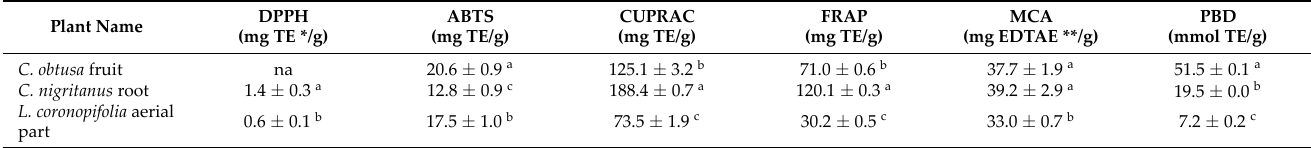
Table 4. Antioxidant activity of the essential oil of the investigated aromatic plants.